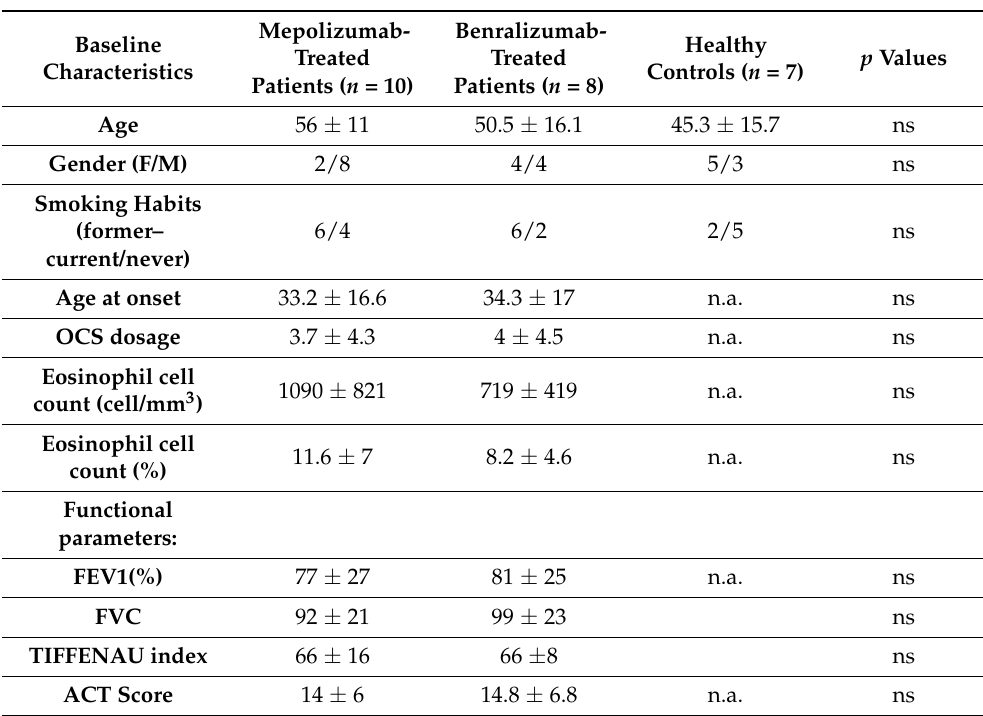
Table 1. Demographic, clinical, immunological, and functional parameters of study population at baseline.